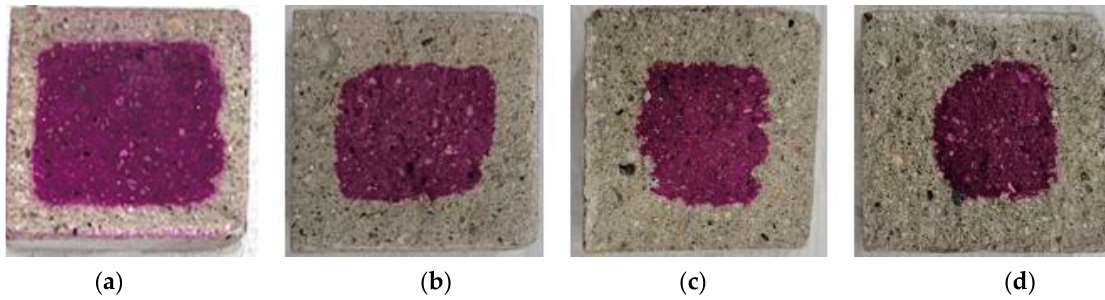
Figure 10. Accelerated carbonation test result of BFS25: ( a ) 1, ( b ) 2, ( c ) 3, and ( d ) 4 weeks.